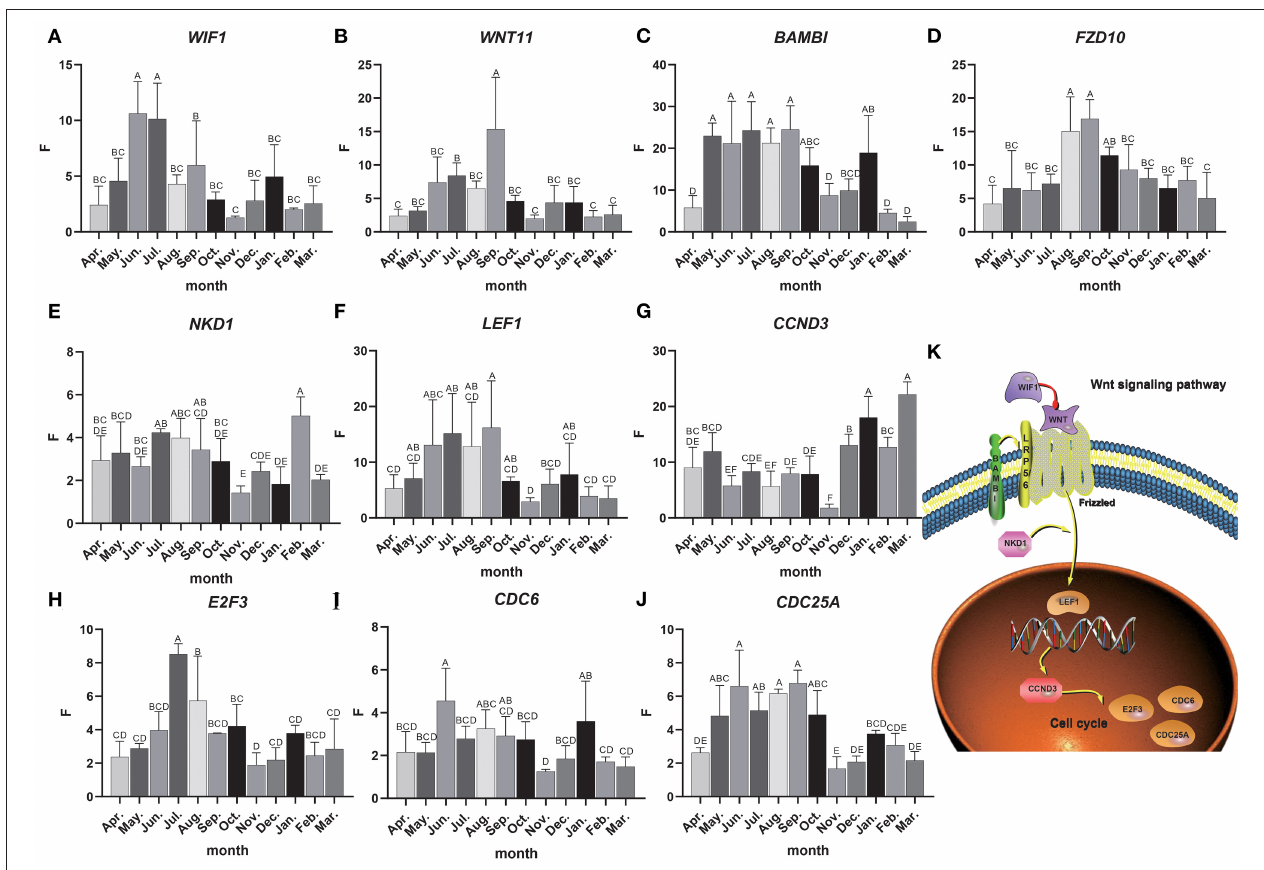
FIGURE 5 | Candidate gene expression analysis. (A–J) The relative expression of candidate genes, the Abscissa indicates the month, the ordinate is the relative expression F, different letters are marked to indicate significant, while the same letters indicate that the differences are not significant, the error bar represents SD. (K) Interactive network control